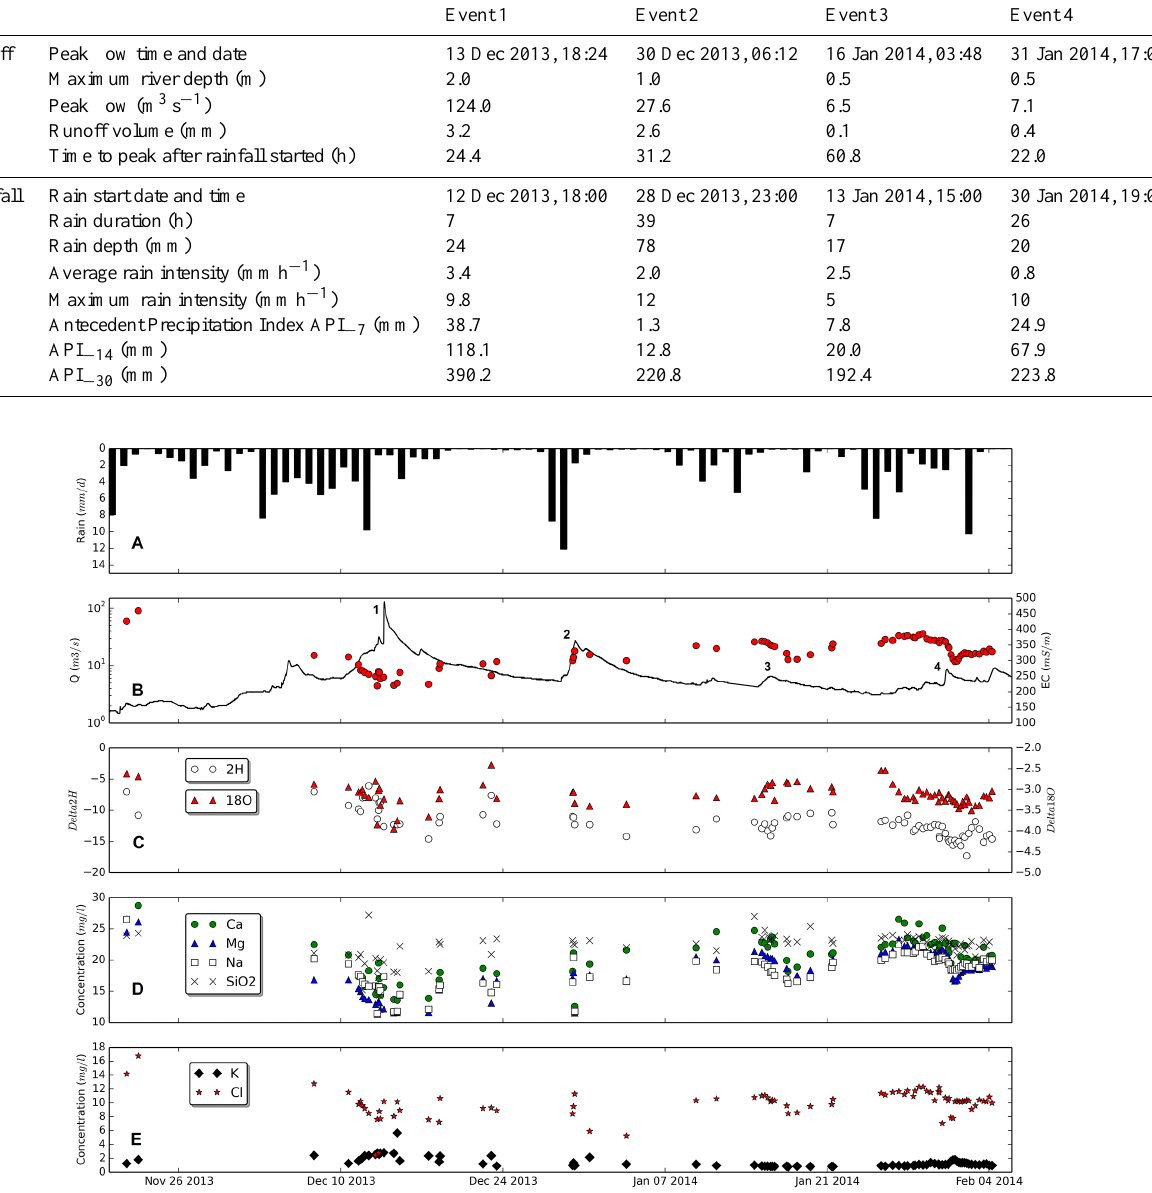
Table 4. Rainfall–runoff relationships observed during the 2013–2014 wet season for the Kaap catchment at the outlet (X2H022 stream gauge) and average precipitation from Koffiekultuur, Nelshoogte Bos, Satico, and the Josefdal border rain stations.